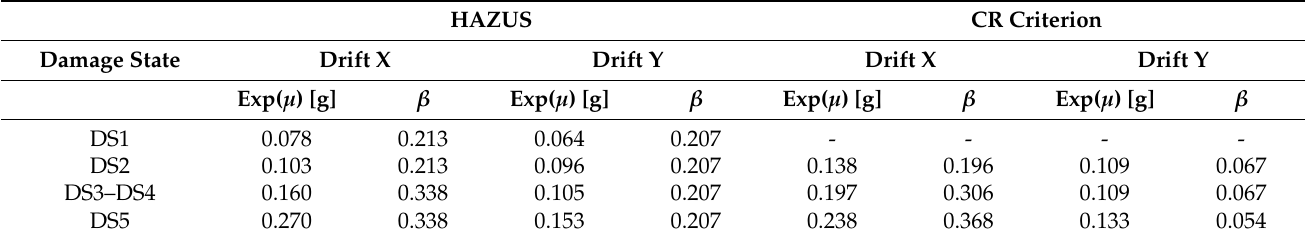
Table 3. Parameters of lognormal fragility curves for X and Y direction and for the adopted IDR damage states thresholds.